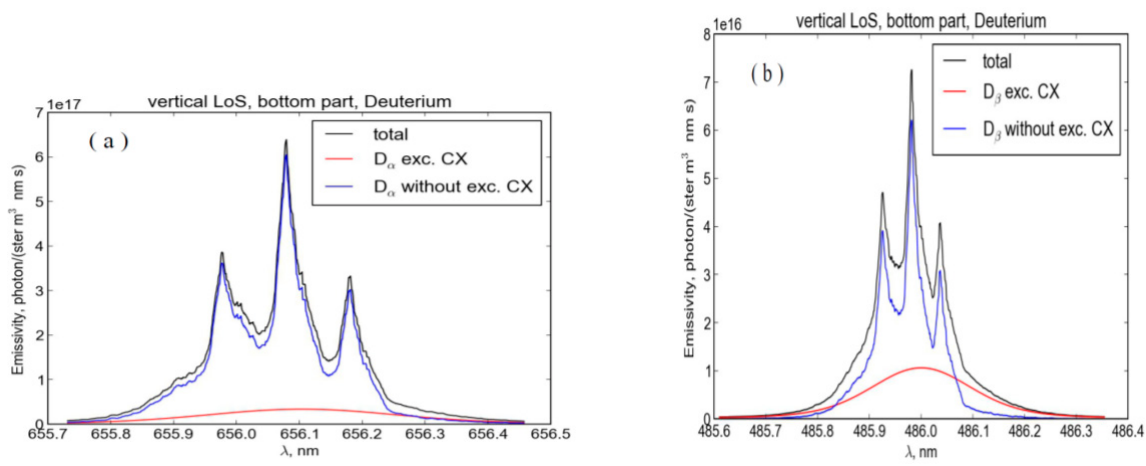
Figure 8. The same as in Figure 7 but for the top part of vertical observation